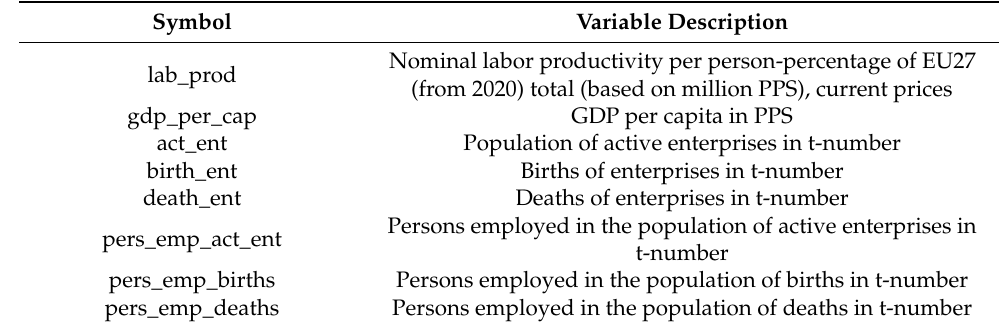
Table 3. Variable descriptions and data series availability.